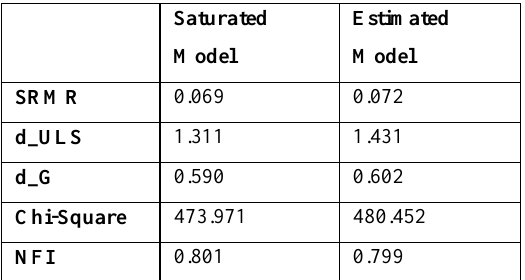
Table 3: Model Fit Indices